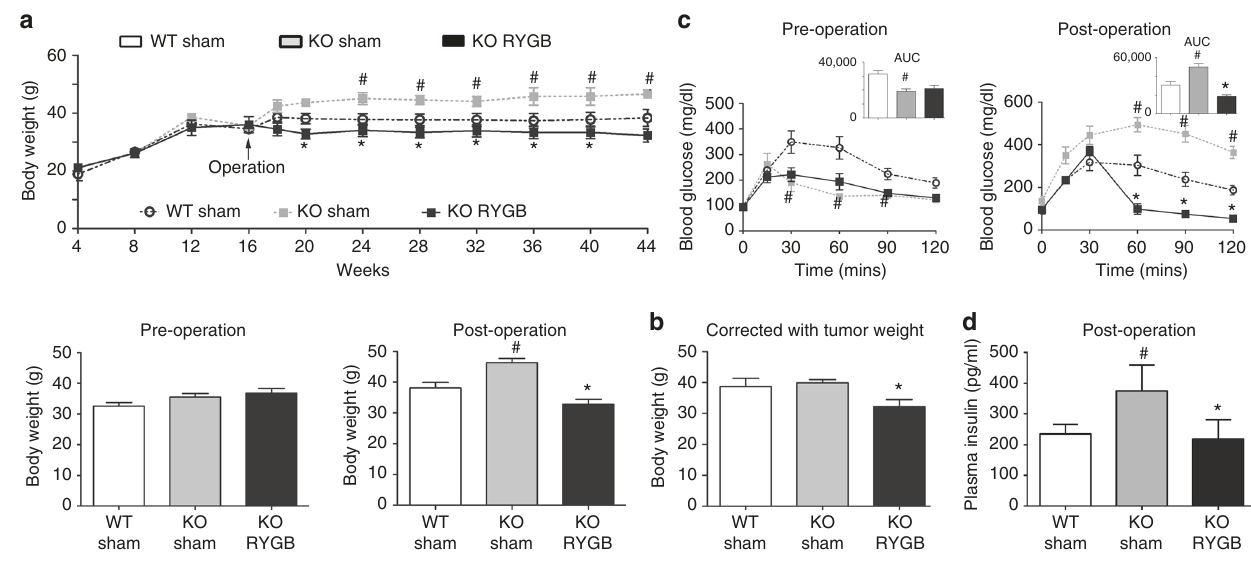
Fig. 3 Body weight and glucose metabolism might before and after RYGB surgery. a RYGB surgery produced a moderate reduction in body weight. b Post- operative body weight corrected with pancreatic cancer weight. c Oral glucose tolerance test before operation (left) at the age of 16 weeks, and after operation at the age of 44 weeks (right). d Plasma levels of insulin after operation at the age of 44 weeks. Values are mean ± SEM. n = 9, 5, 5 for WT sham, Ngn3-Tsc1 − / − (KO) sham, Ngn3-Tsc1 − / − (KO) RYGB, respectively. Statistical differences were analyzed by one-way ANOVA followed by the Student ’ s t - test. # P < 0.05 Ngn3-Tsc1 − / − (KO) sham vs WT sham, * P < 0.05 Ngn3-Tsc1 − / − (KO) RYGB vs. Ngn3-Tsc1 − / − (KO)